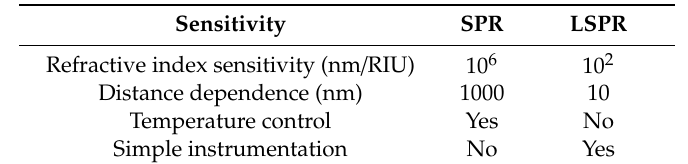
Table 1. The sensitivity range comparison of surface plasmon resonance (SPR) and localized surface plasmon resonance (LSPR) [22].